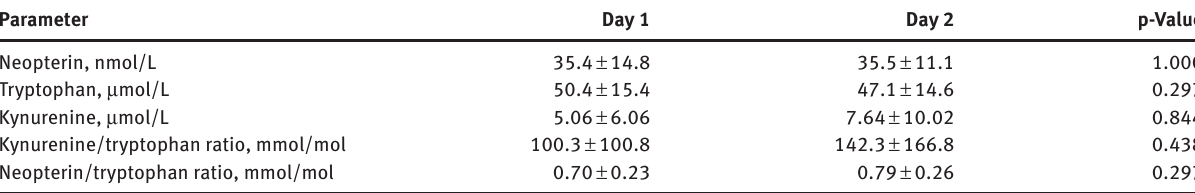
Table 3: Differences in biomarker concentrations in wound secretions from the axilla in breast cancer patients after the surgery. Parameter